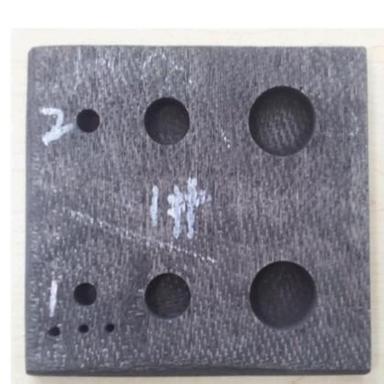
The excess temperature image of sample A at time t = 1.333 s.